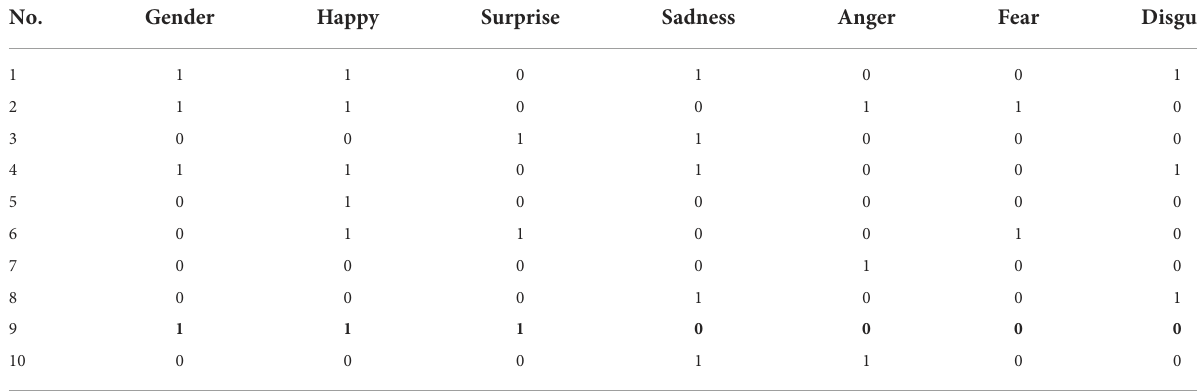
TABLE 4 The data conversion of reported emotional statues by questionnaire form.